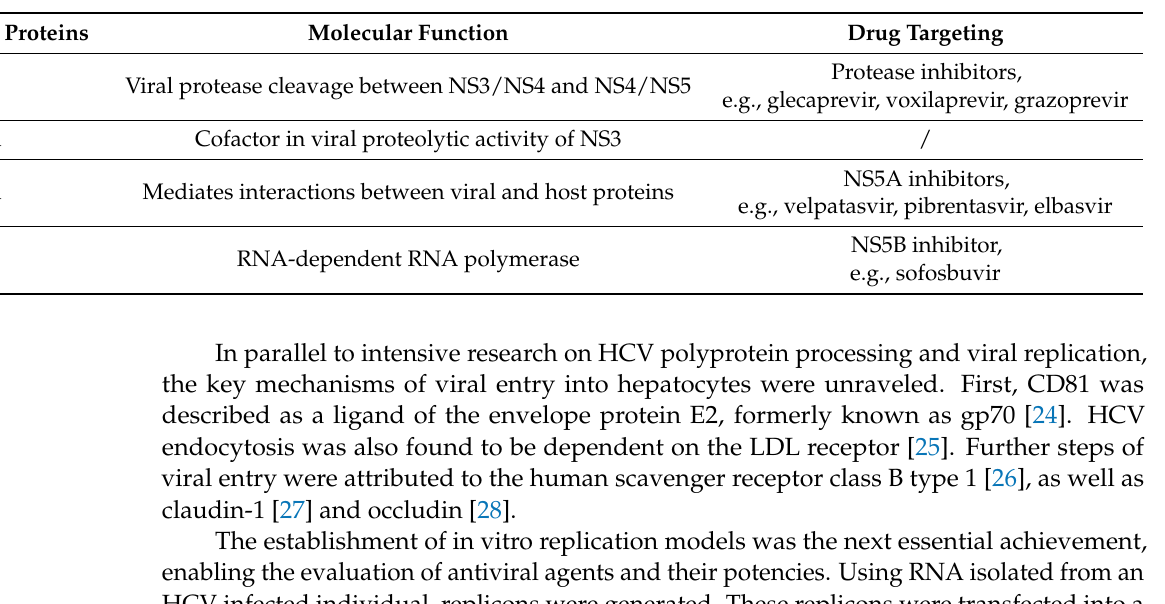
Table 1. Nonstructural proteins of the hepatitis C virus with according molecular functions and targeting by currently recommended direct-acting antiviral